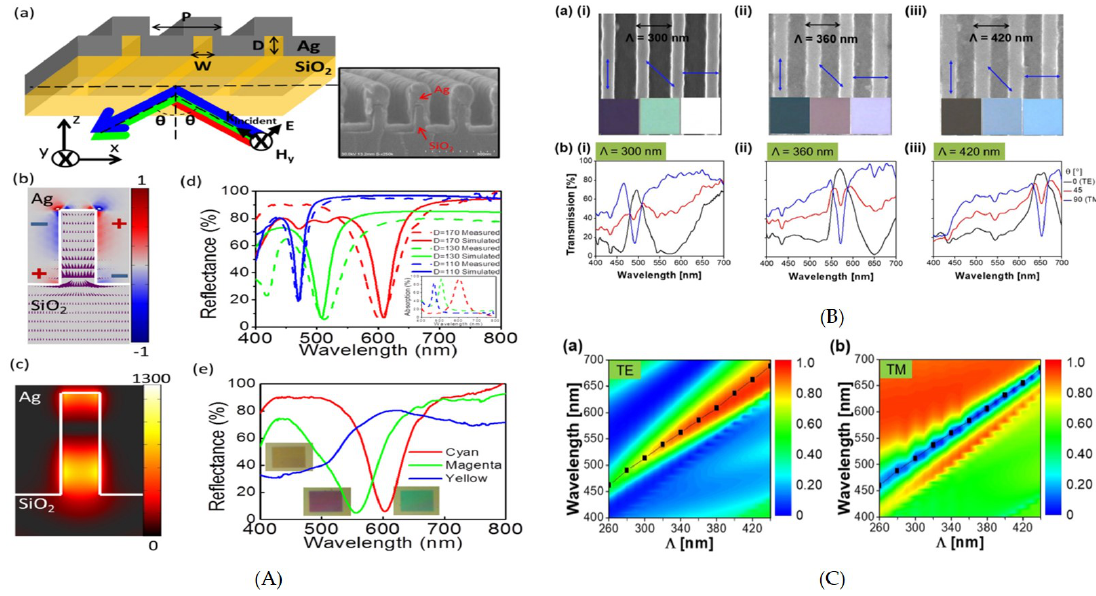
Figure 4. ( A ) Schematic of plasmonic nano-cavity along with its fabricated device is illustrated. The charge distribution and Poynting vector direction is shown with the help of a simulator. The impact of dimension of nanoslits on reflection spectra is further shown theoretically and experimentally and results for CMY colors are produced [100]. ( B ) Scanning Electron Microscope (SEM) images of fabricated multicolor pixel and their spectral transmission. Camera image of vivid color produced shows its dependency on the grating period and angle of polarization ( C ) Verification of GMR for TE and TM mode transmission spectra